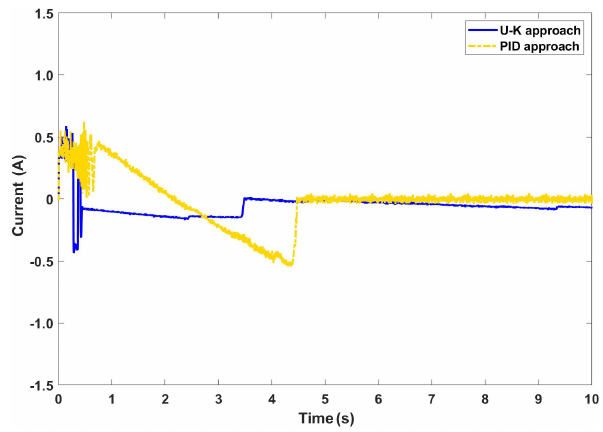
Figure 7. Experimental results of the transient performance of U–K and PID.